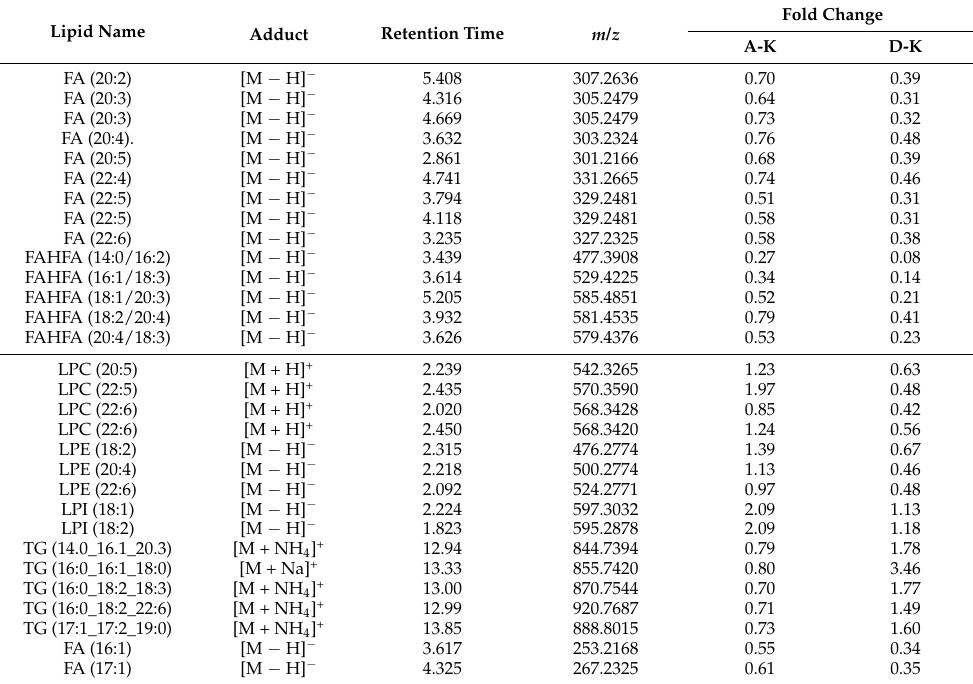
Table 1. Significant (VIP) lipids obtained by PLS-DA model on the set of all detected plasma lipids.